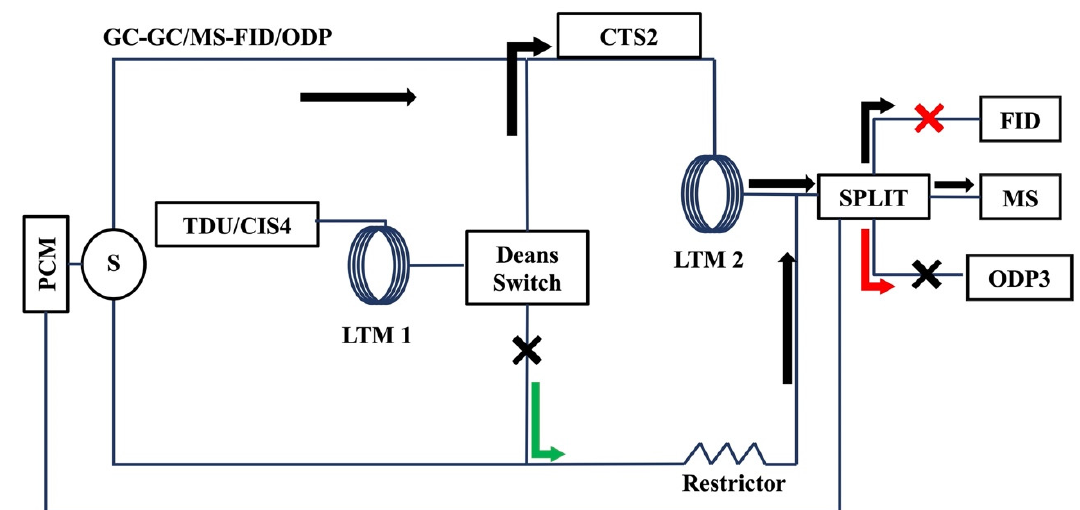
Figure 5. Selectable 1D/2D GC/MS-FID/ODP. Black arrows indicate sample separation by GC-GC for library-building purposes. Red arrows indicate flow the path when operating the ODP. The 1D flow path does not include the LTM2 and is indicated with the green arrow.